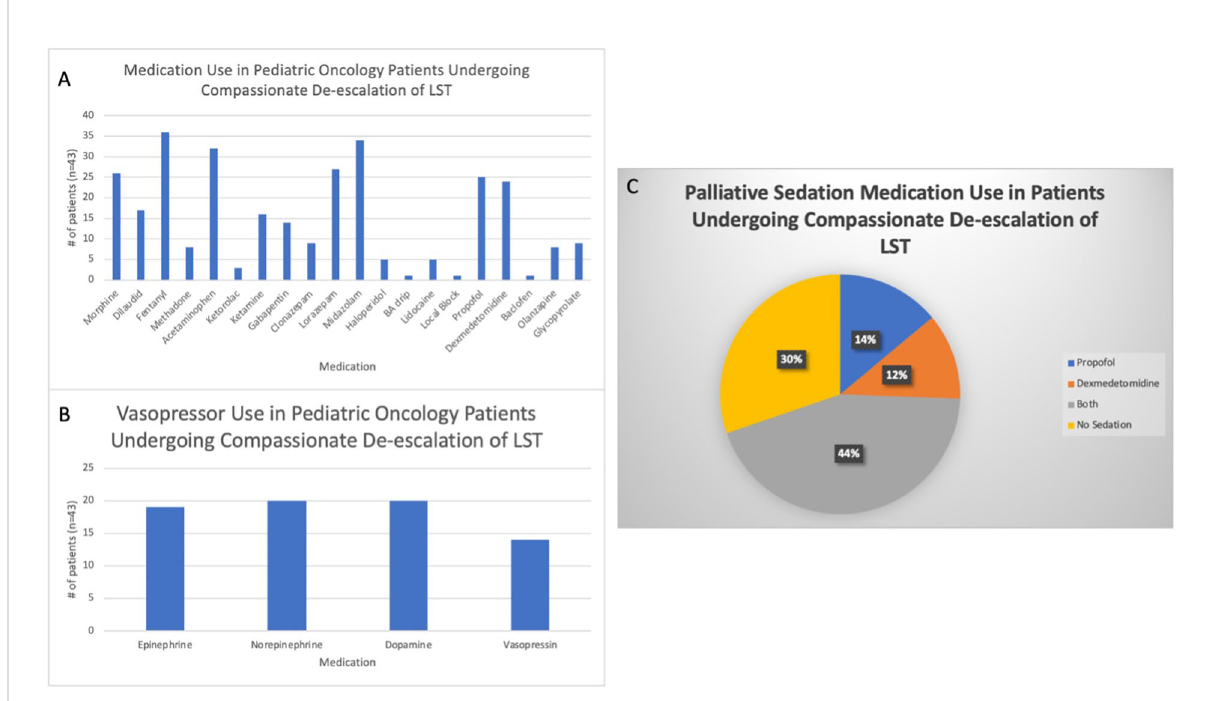
FIGURE 1 Medications used to treat pediatric oncology patients during compassionate de-escalation of life-sustaining treatments (LSTs). (A) All medications prescribed to the study population to treat symptoms at the end of life. BA= Benadryl/Ativan. (B) Vasopressor medications used to treat hypotension in the study cohort. (C) Use of palliative sedation therapy, speci fi cally dexmedetomidine and propofol, during the end of